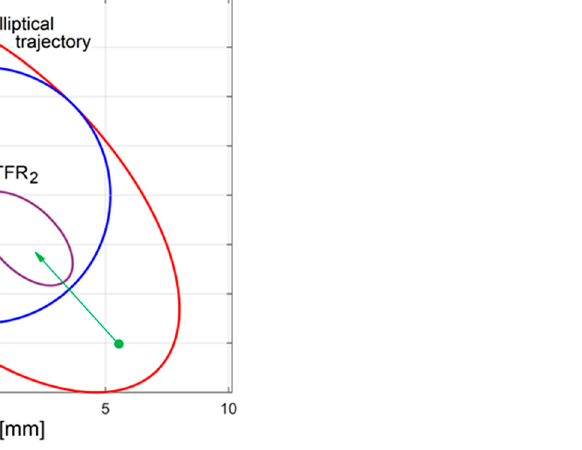
Figure 17. The evolution of TFR 2 generated by circular fitting on an elliptical trajectory (simulation). The least square circle (14.2 μ m radius, with center at x c = − 3.3 μ m and y c = − 1.9 μ m)